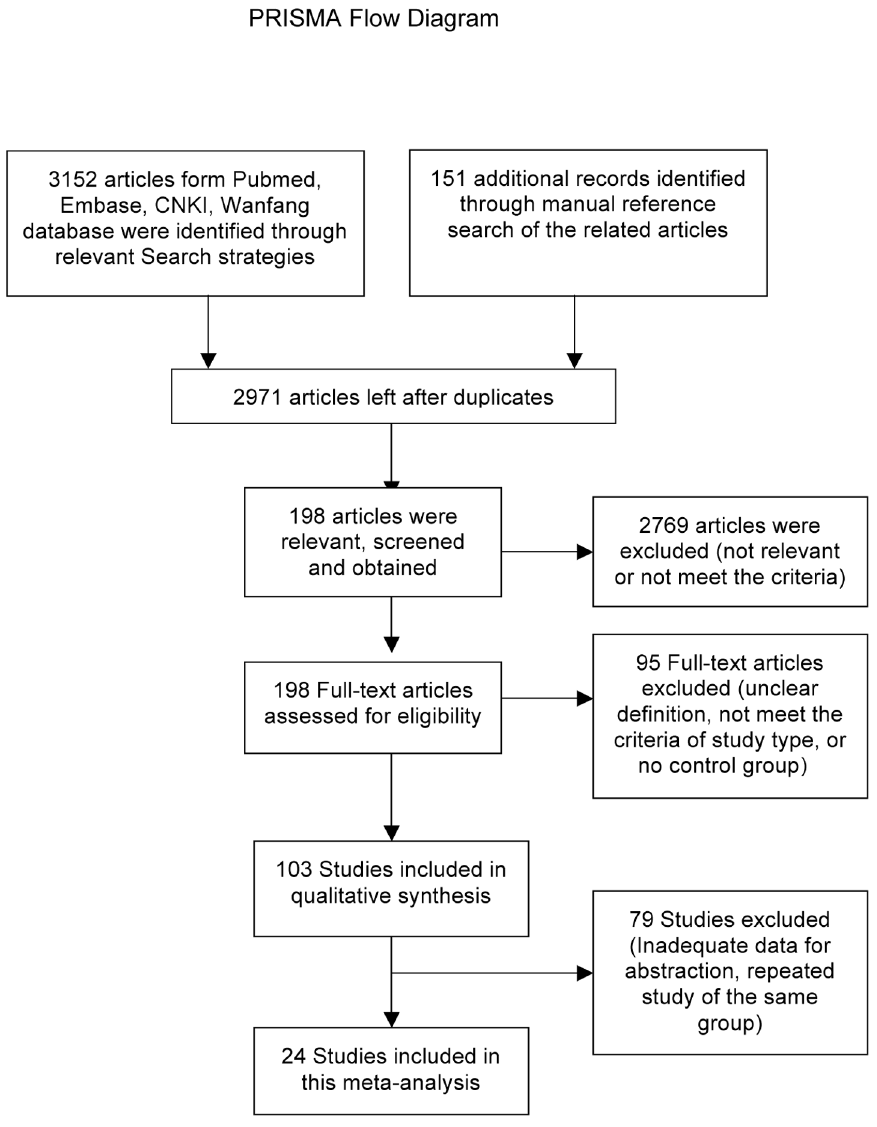
Figure 1 PRISMA Flow Diagram.